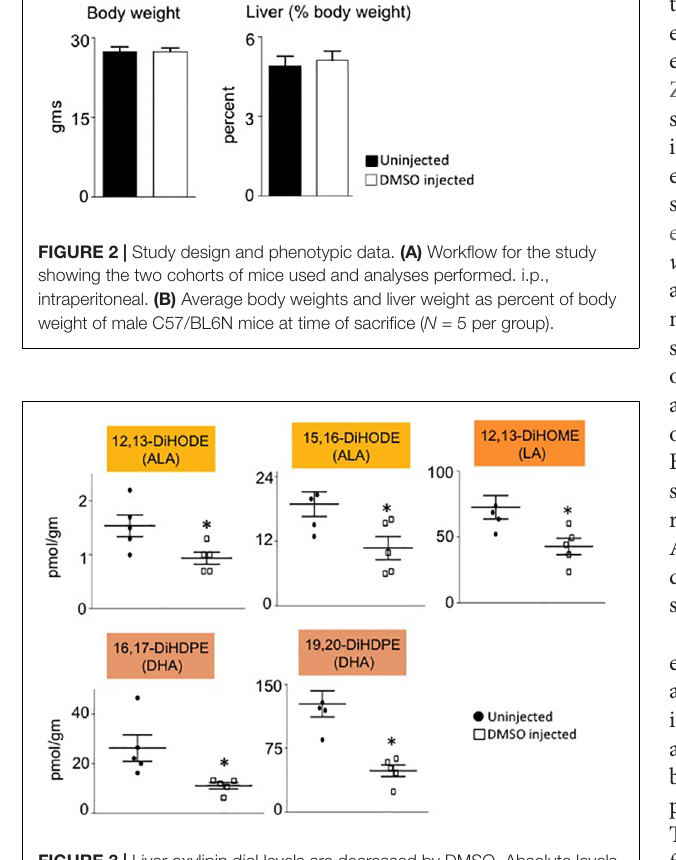
FIGURE 3 | Liver oxylipin diol levels are decreased by DMSO. Absolute levels of diols that are significantly decreased in liver of mice injected with 1% DMSO ( (cid:3) ) compared to uninjected controls ( ). The fatty acid from which the oxylipin was derived is shown in parentheses. N = 5 mice per group. Data are (cid:32) presented as ± SEM. ∗ Significantly different from uninjected control, P ≤